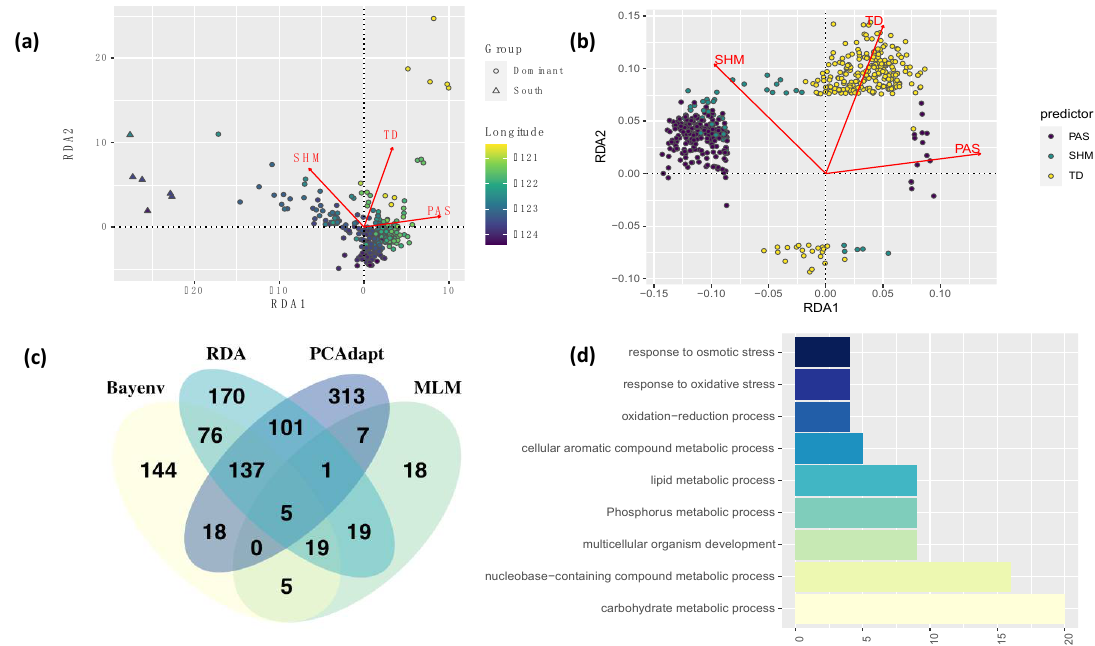
Figure 2. Results of the Genotype-Environment association (GEA) analyses. Results of the multivariate RDA analysis by ( a ) individuals along longitudinal gradients (color scale), and ( b ) SNP markers for significant environmental variables such as Precipitation as snow (PAS), Summer Heat Moisture Index (SHM), and continentality (TD) based on 20.3 k genome-wide SNP markers identified for coastal Douglas-fir; ( c ) Venn diagram of combined results of all GEA methods; and ( d ) Main gene ontologies of genes identified in all GEA methods.